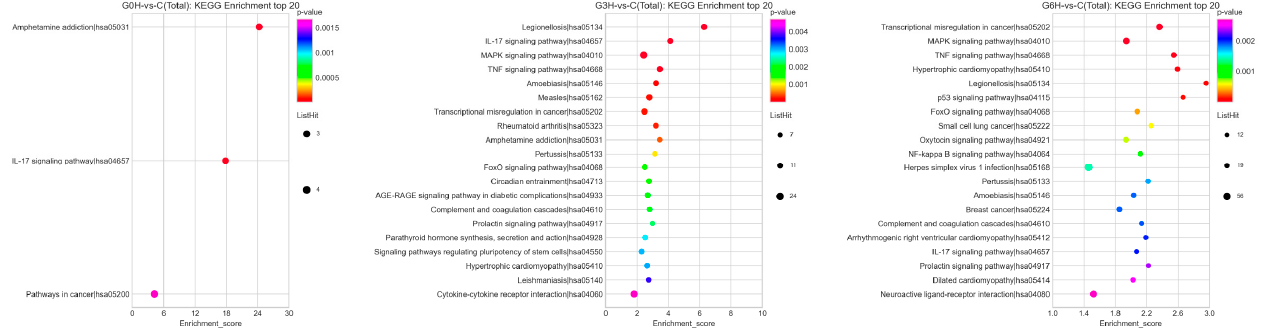
Figure 4. Enriched KEGG pathways were sorted by the -log10P-value, and the top 20 pathways were portrayed using bubble plots.